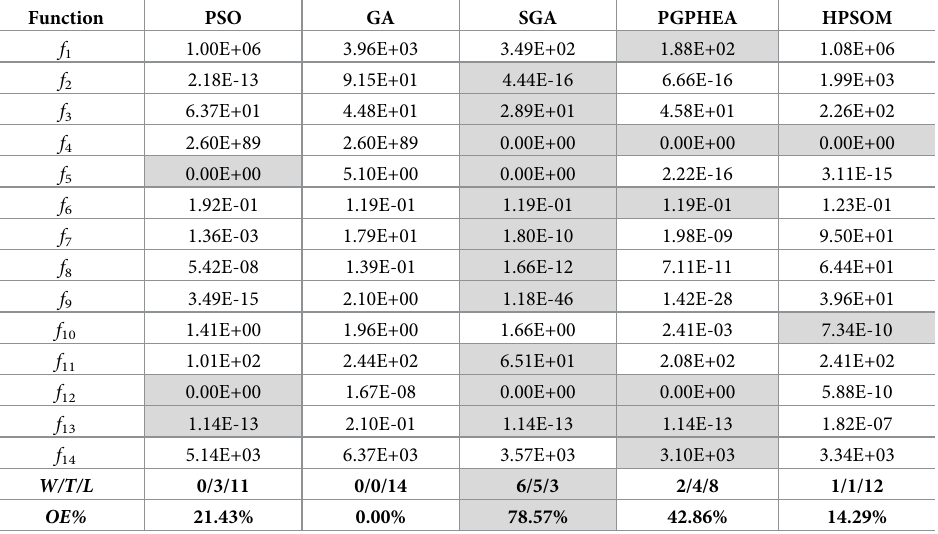
Table 4. Comparison of maximum error in finding global optimum of functions f 1 - f 14 .